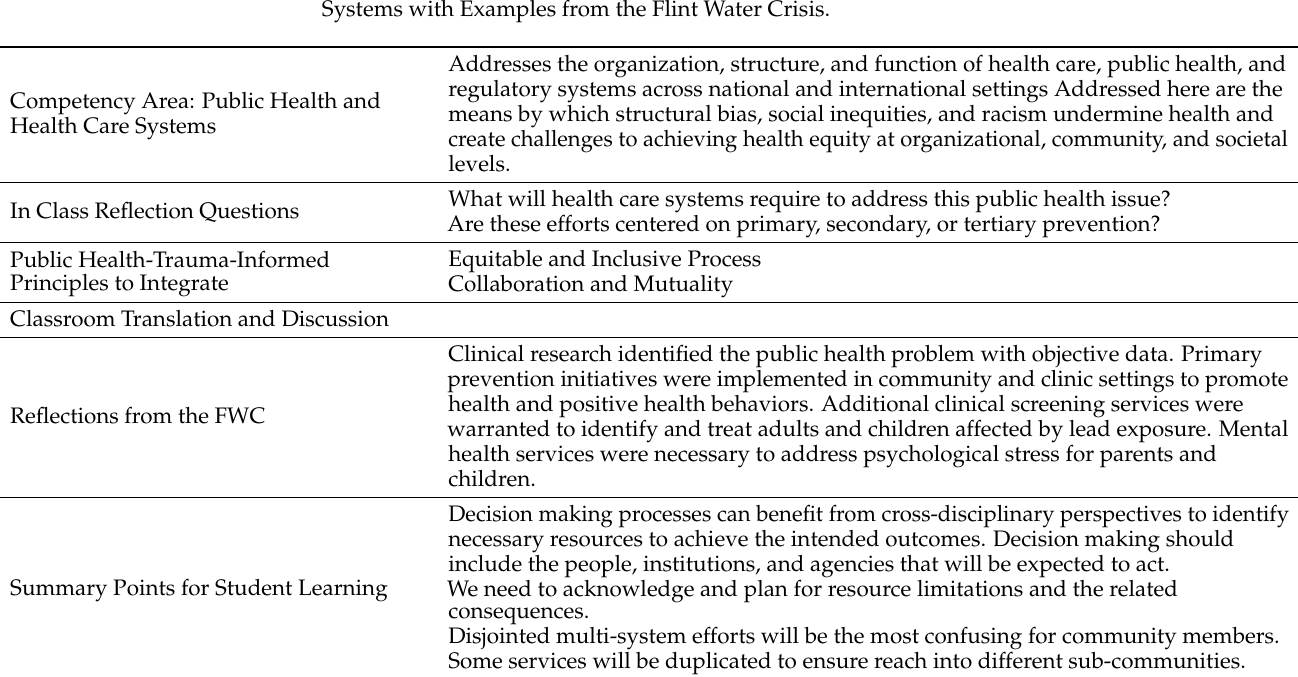
Table 6. Trauma-Informed Principles in Public Health: Addressing Public Health and Health Care Systems with Examples from the Flint Water Crisis.